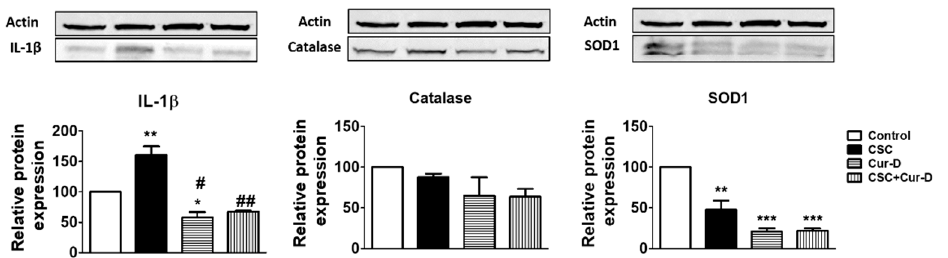
Figure 6. Effect of Cur-D on IL-1 β and antioxidant enzymes (catalase and SOD1): Differentiated U1 macrophages were concomitantly treated with CSC (10 µg/mL) and Cur-D (0.1 µM) continuously for 3 days and cells were harvested at the end of the treatment. The expression of IL-1 β , antioxidant enzymes (catalase and SOD1) proteins were measured in differentiated U1 cells ( n = 3) by Western blot. One-way ANOVA with Tukey’s post-hoc test was applied to compare between multiple groups.*, **, and *** represent p < 0.05 and p < 0.01, p < 0.001, respectively when compared to control. # and ## represent p < 0.05 and p < 0.01, respectively, when compared to CSC.